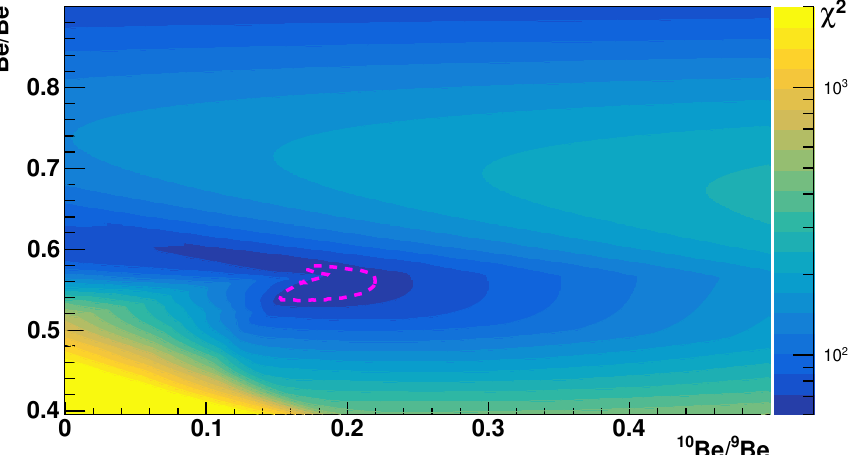
Figure 4. A map of χ 2 configurations for beryllium events collected by PAMELA-ToF in the 0.65–0.85 GeV/n region. The 68% confidence interval is shown as a red dashed